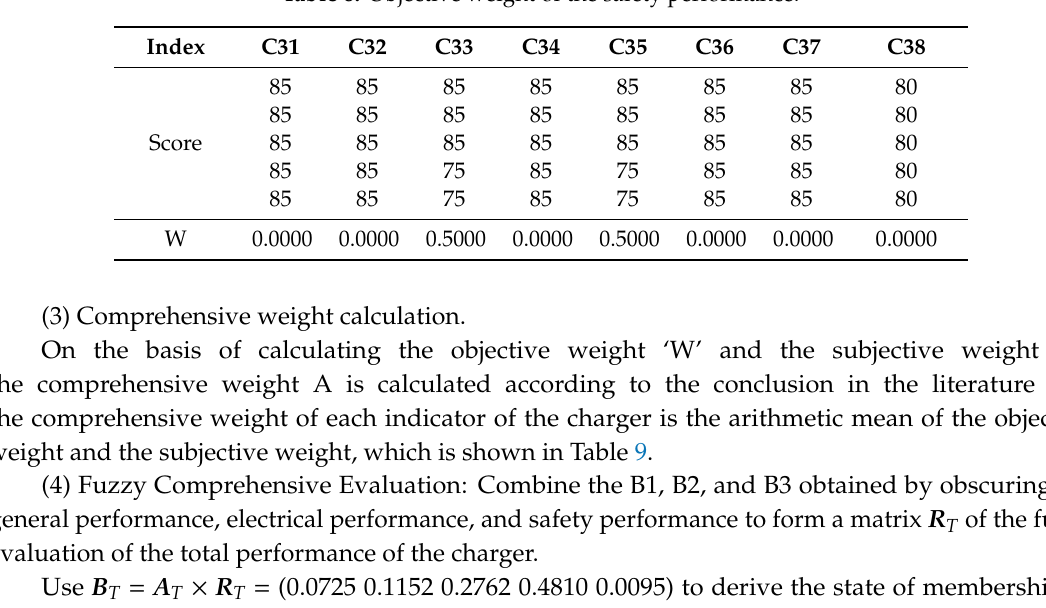
Table 8. Objective weight of the safety